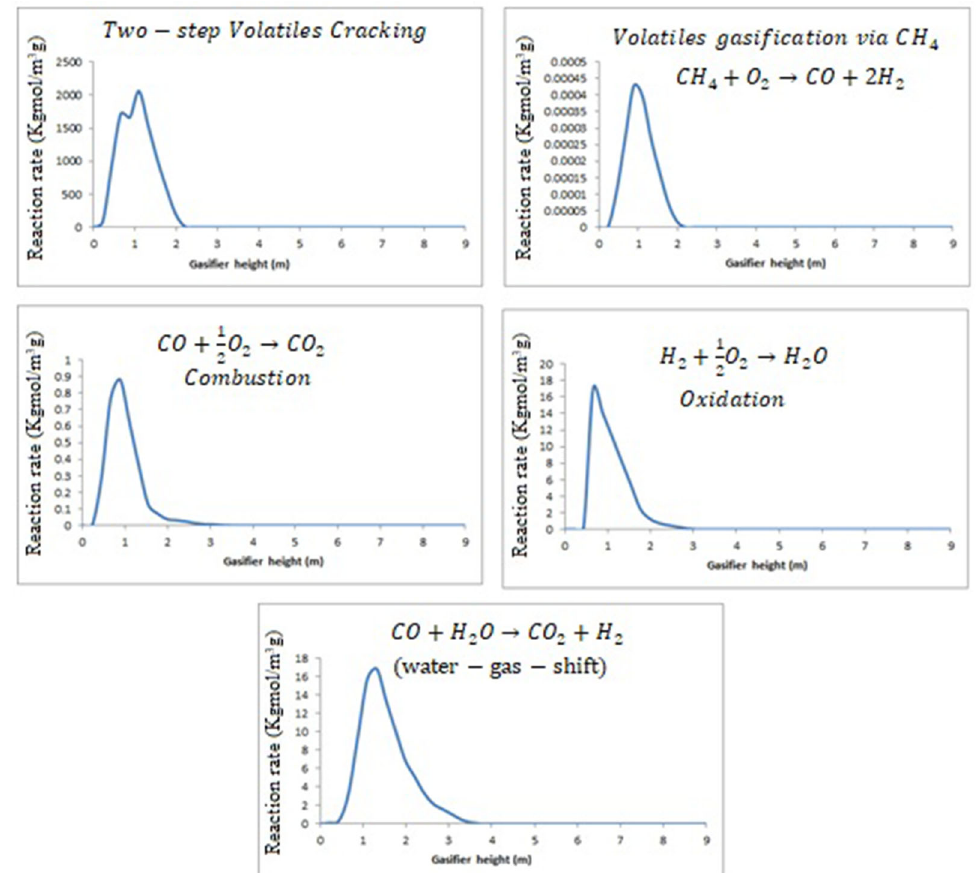
Fig. 11 Homogenous reaction rates along gasifier